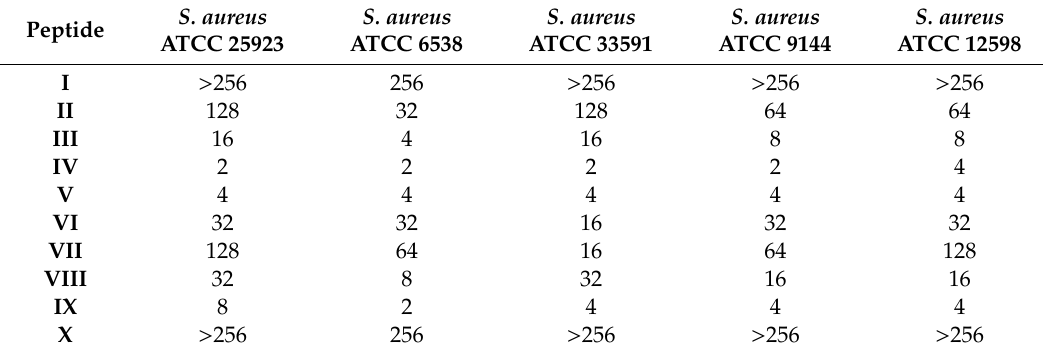
Table 3. The MIC values ( µ g / mL) of the test peptides against reference strains of S. aureus.